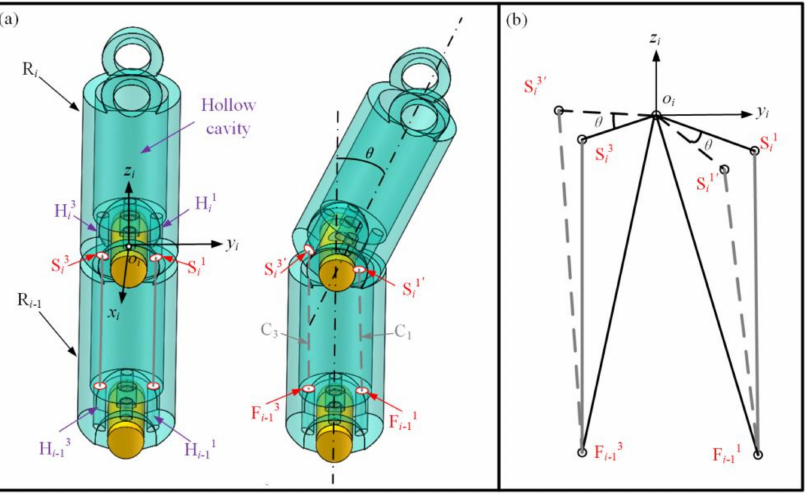
Figure 5. Analysis of the changes in cable length: ( a ) state of the segment before and after bending; ( b ) change in the length of cables C 1 and C 3